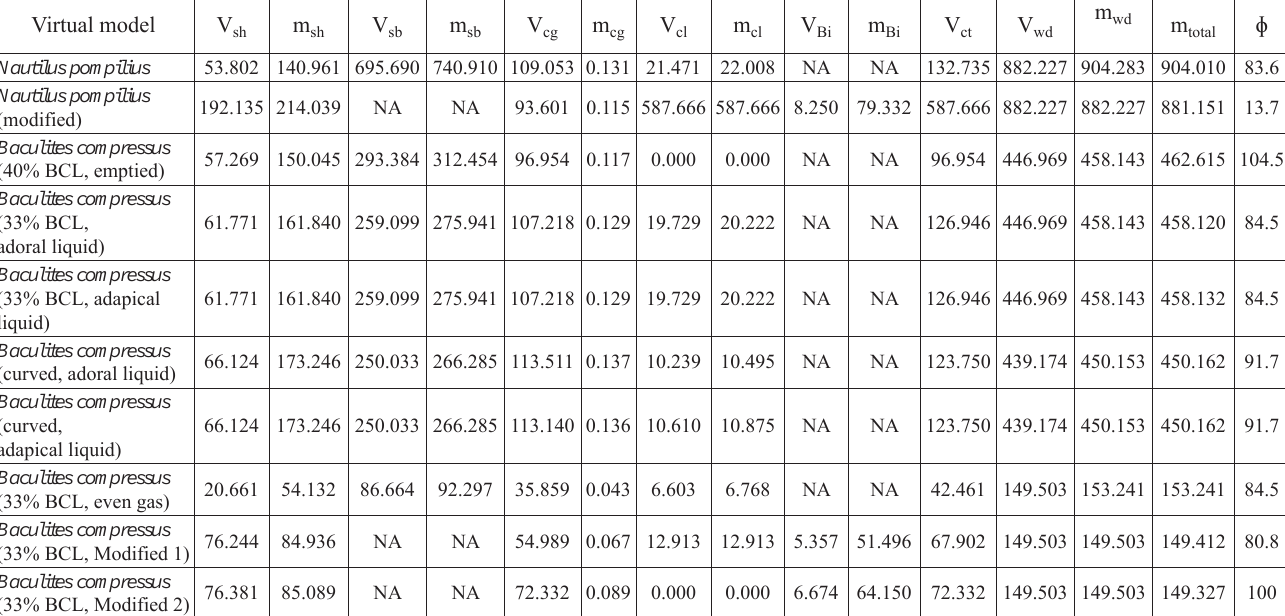
Table 3. The volumes (V, in cm 3 ) and masses (m, in g) of the shell (sh), soft body (sb), cameral gas (cg), cameral liquid (cl), bismuth counterweight (Bi), total camerae (ct), water displaced (wd), and total mass for each virtual model. These metrics were used to compute the percentage of the phragmocone emptied for a neutrally buoyant condition ( Φ ). NA, not